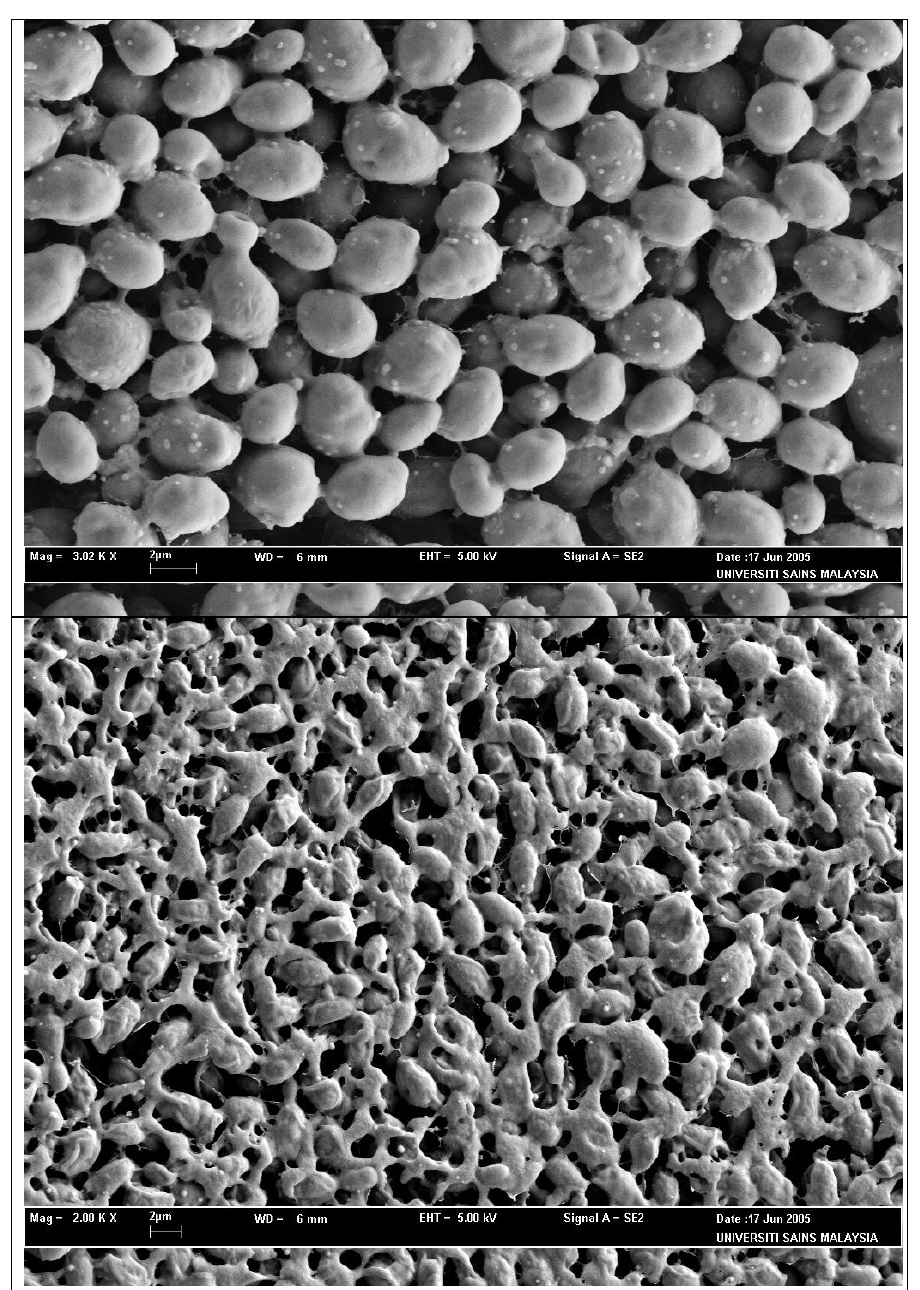
Figure 2. Scanning electron microscope photomicrograph of the untreated ( a ) and extract-treated ( b ) cells of Candida albicans